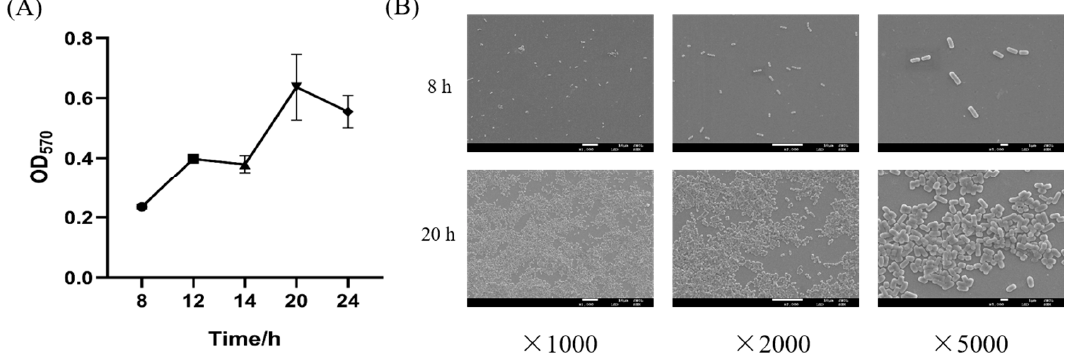
Figure 1. Biofilm formation curve of L. plantarum Y42 ( A ); SEM images of the L. plantarum Y42 biofilms on glass at 8 and 20 h ( B ).